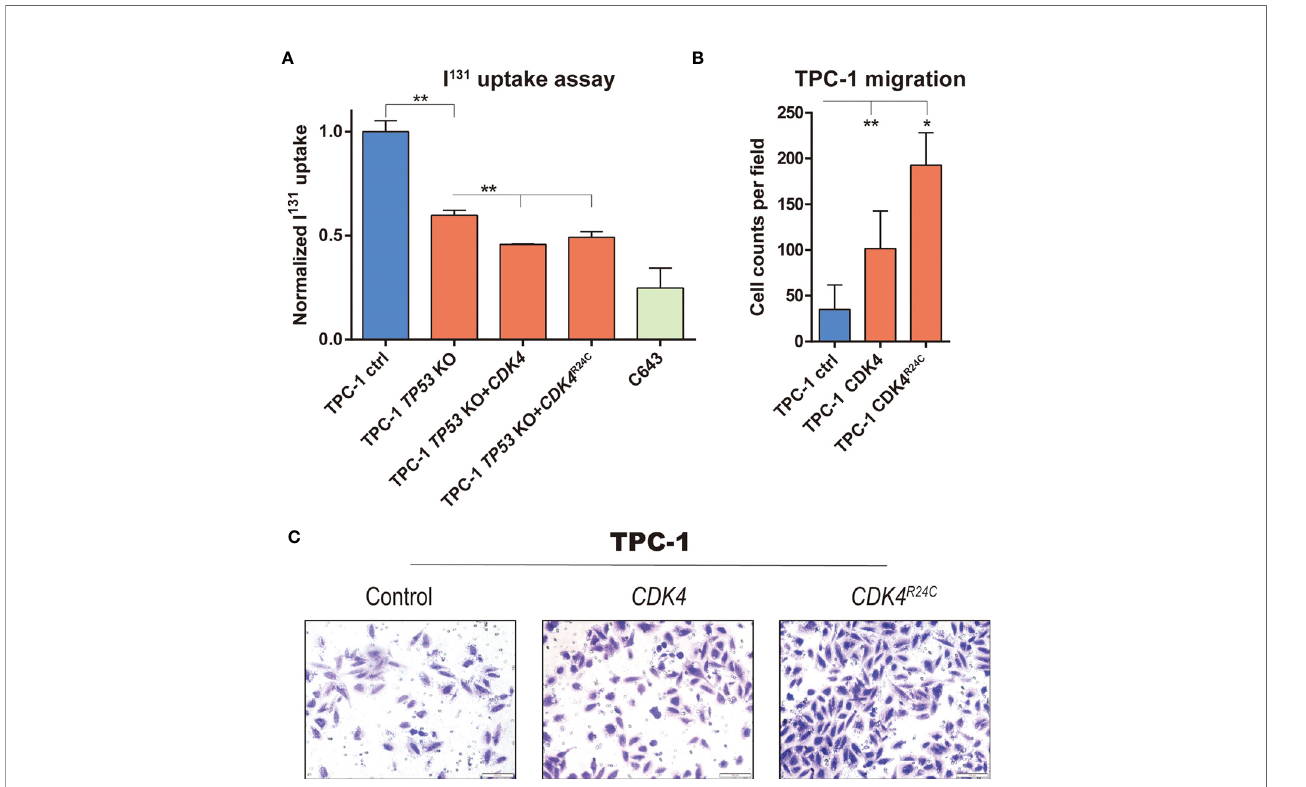
FIGURE 4 | The impact of mutations in TP53 and CDK4 on migration and differentiation of PTC cells. (A) 131 I uptake in TPC-1 cell with different modi fi cation ( TP53 knockout, and CDK4 / CDK4 R24C overexpression), with C643 as positive control; (B) Representative image capture and (C) quanti fi cation of transwell assay in TPC-1 and CDK4/CDK4 R24C overexpression. *, P value < 0.05; **, P value <